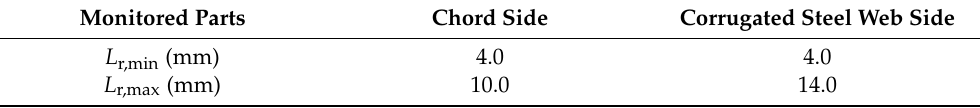
Table 4. Interpolation